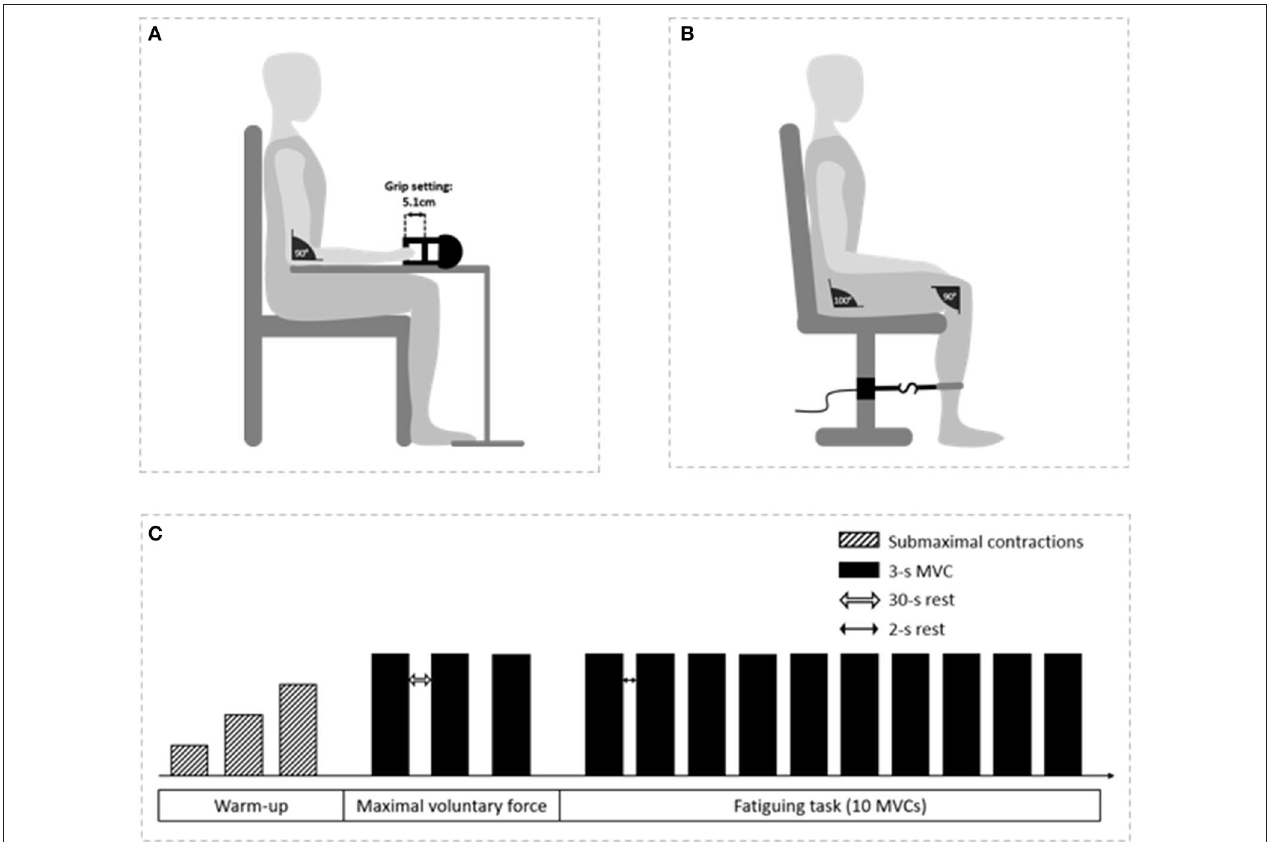
FIGURE 3 | Illustration of the neuromuscular assessments. Participant’s position for finger flexor (A) and knee extensor (B) assessments and schematic representation of the protocol (C) .